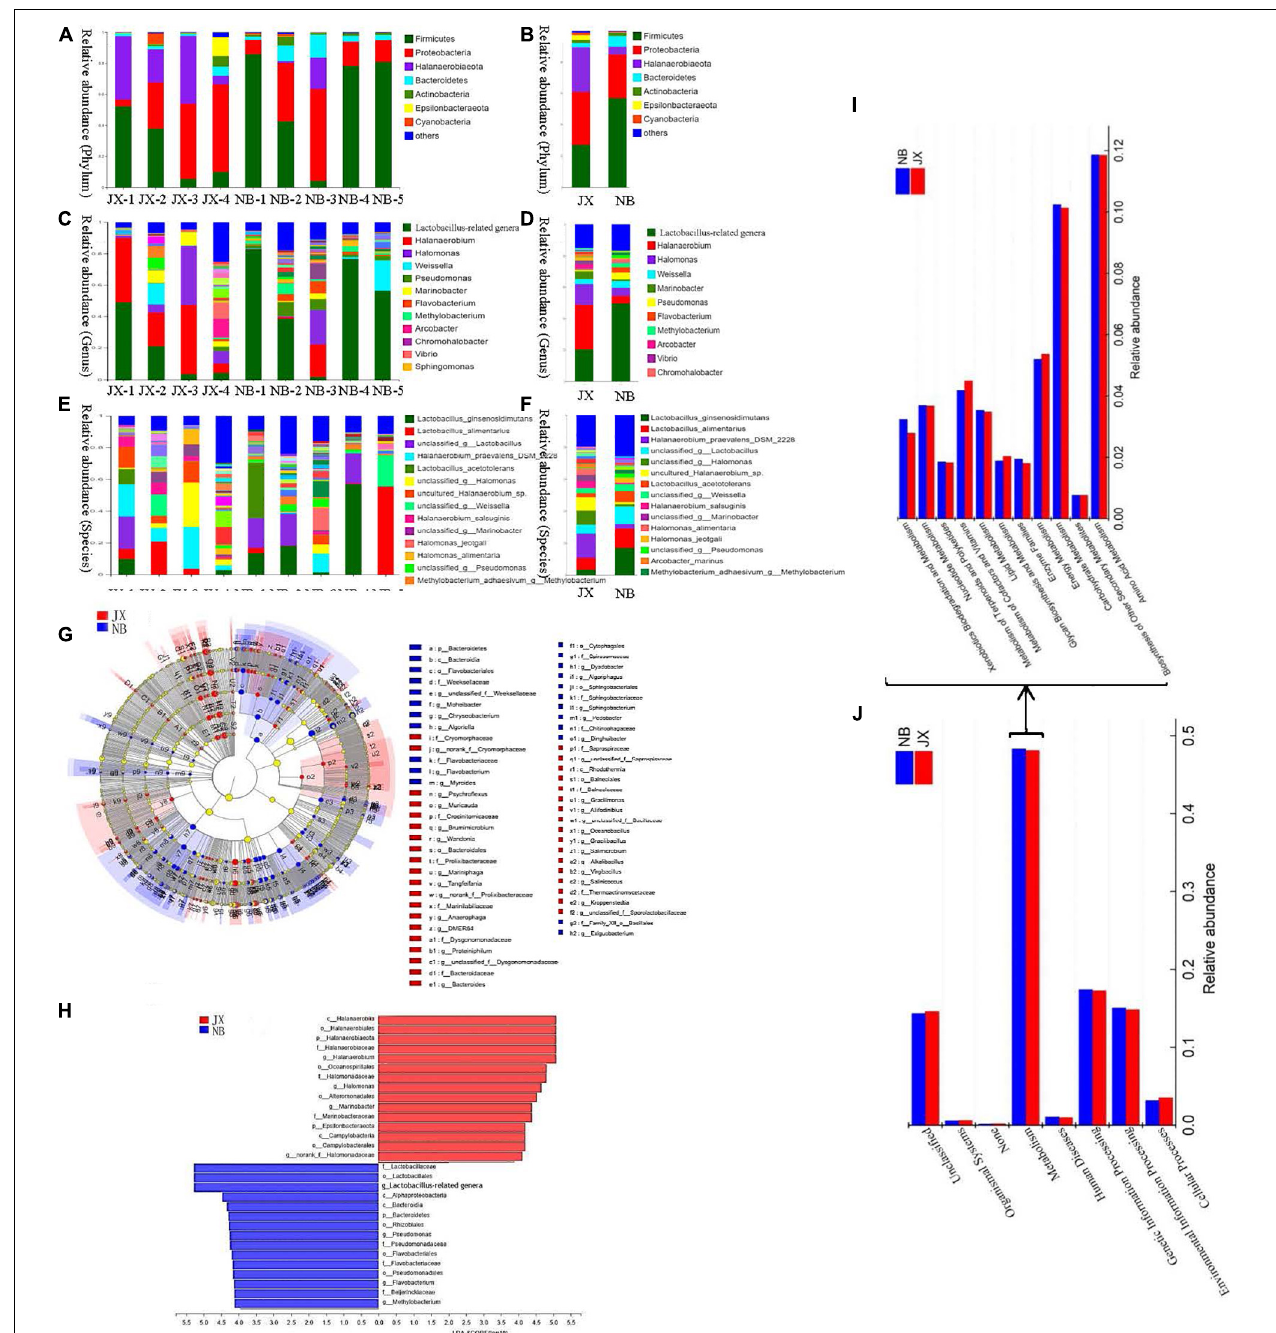
FIGURE 2 | Composition, LEfSe comparison, LDA score and the predictive functions of bacterial community between traditional fermentation Xuecai (JX) and modern fermentation Xuecai (NB). (A,B) Composition of bacterial community at phylum level; (C,D) composition of bacterial community at genus level; (E,F) composition of bacterial community at species level; (G,H) LEfSe comparison and LDA score; (I,J) : the relative abundance of KEGG pathways (level 1) and the relative abundance of pathways in metabolism (level